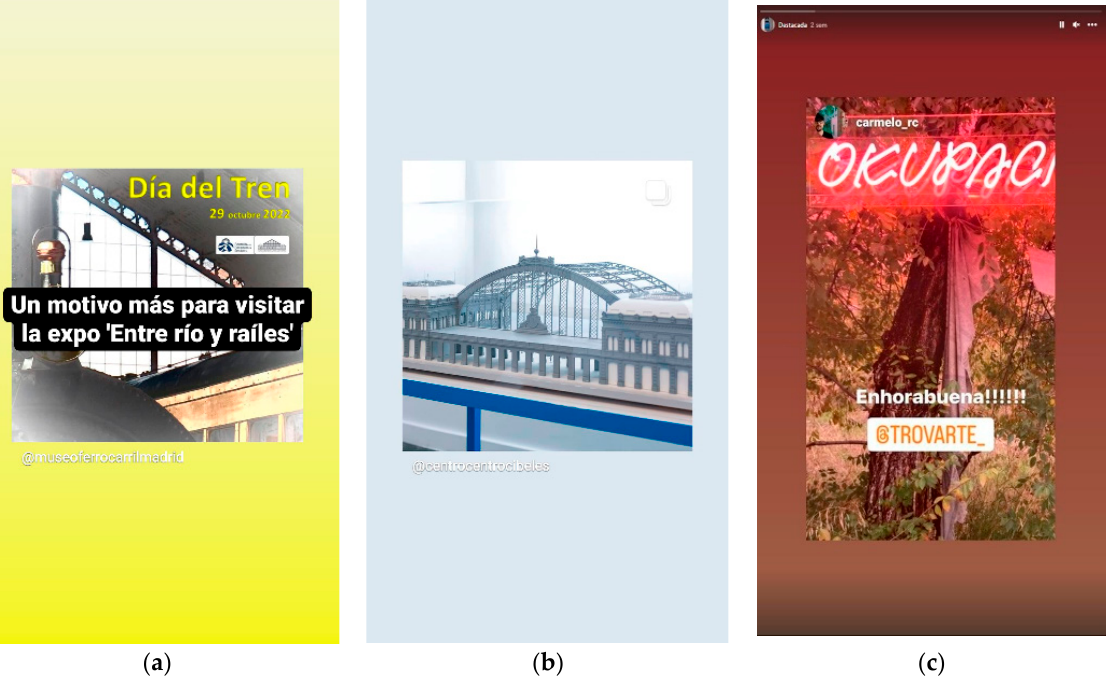
Figure 15. Presence of the research on Instagram through: ( a ) the profiles of the Railway Museum of the Spanish Railways Foundation (FFE); ( b ) the Madrid City Council; and ( c ) a citizen (the prominent architect and activist Carmelo Rodríguez, founder of Enorme Estudio ).